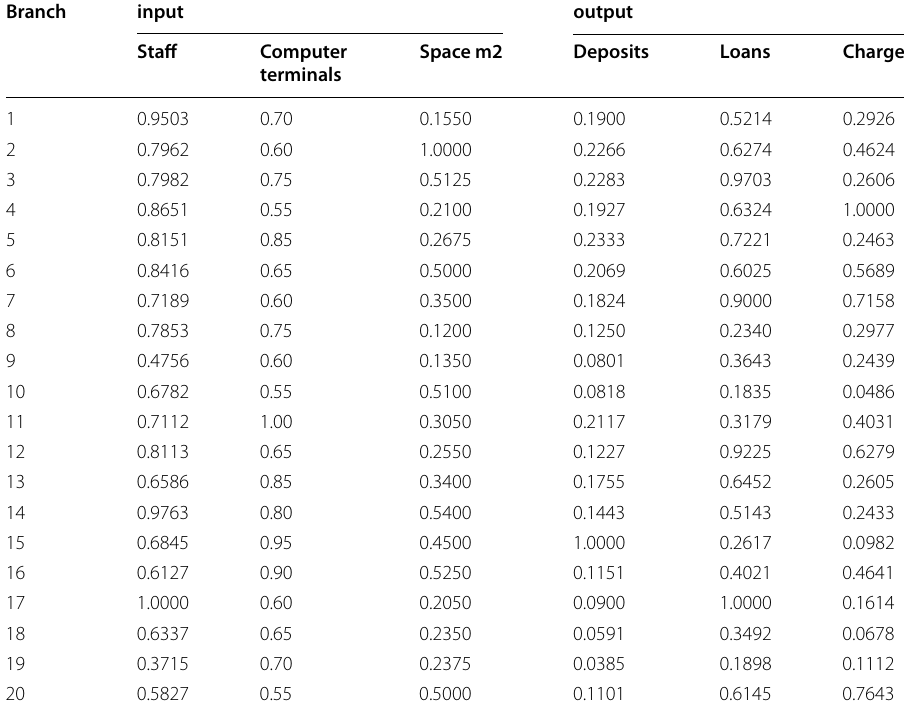
Table 4 Example 3: DMUs’ data [extracted from (Amirteimoori and Kordrostami 2005, p. 689)]